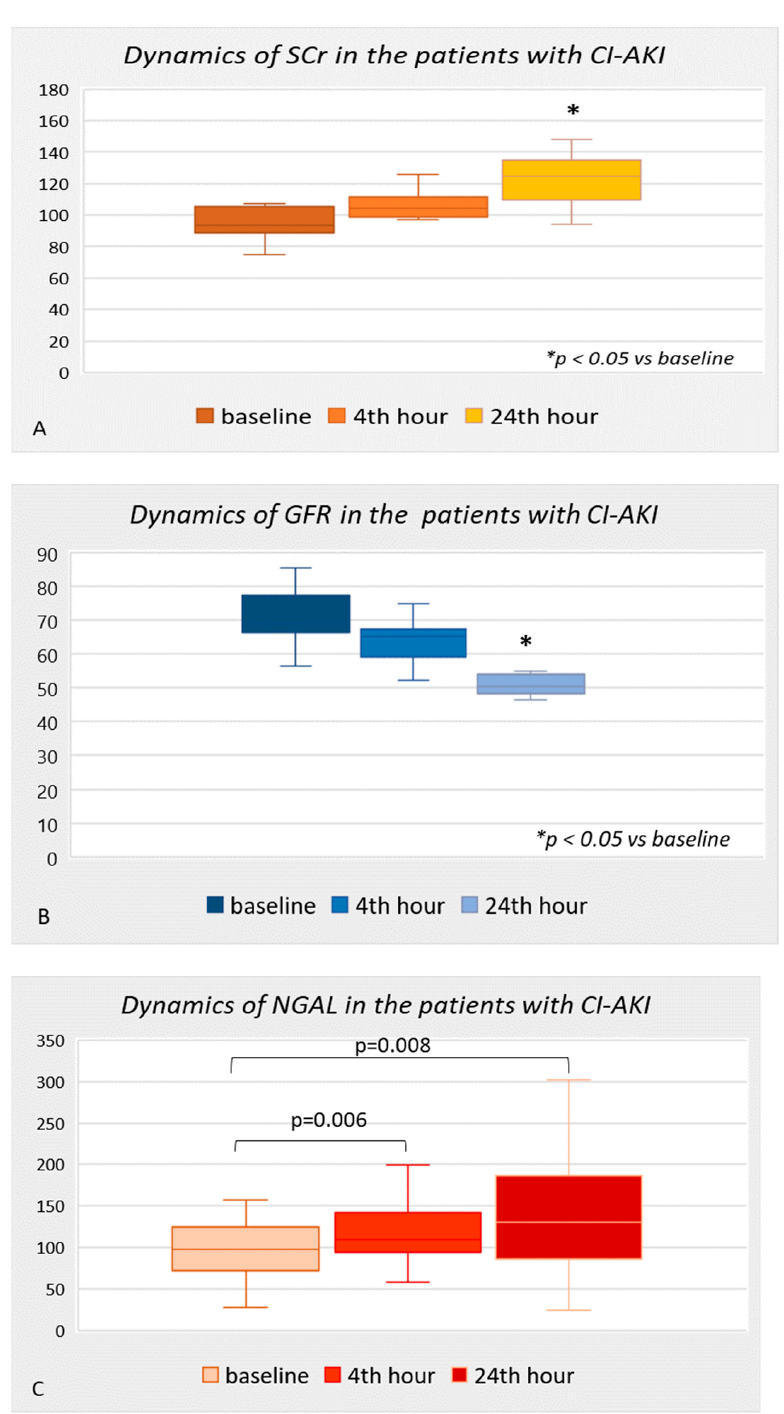
Figure 1. Dynamic changes in all biomarkers in the group of patients with contrast-induced acute kidney injury (CI-AKI). Panel ( A )—dynamics of serum creatinine; Panel ( B )—dynamics of GFR; Panel ( C )—dynamics of NGAL; *—comparison of biomarkers at 24th hour versus baseline values. SCr—serum creatinine (µmol/L); GFR—glomerular filtration rate (mL/min/1.73 m 2 ); NGAL—neutrophil gelatinase associated lipocalin (ng/mL).